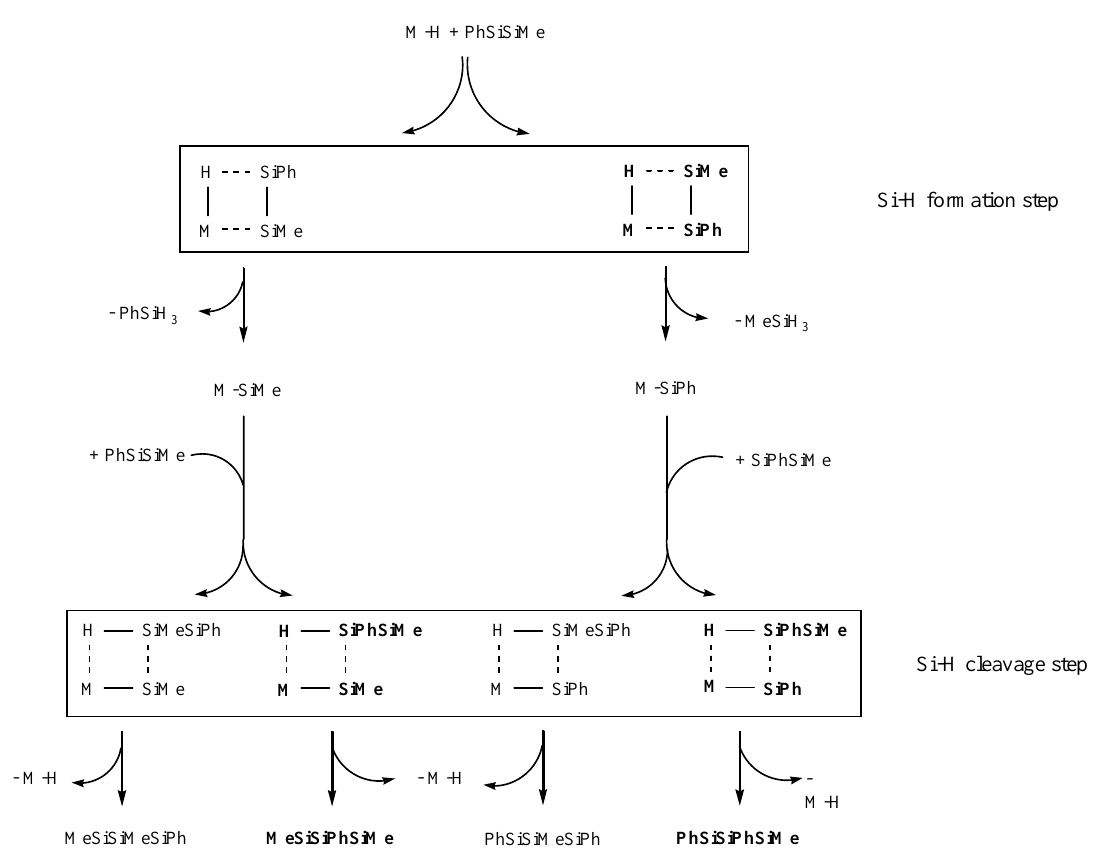
Figure 3. Enhanced reactivity of the phenylsilyl unit compared to the methylsilyl unit. Preferred transition states and isomers (all hydrogen atoms on silicon omitted for clarity) printed